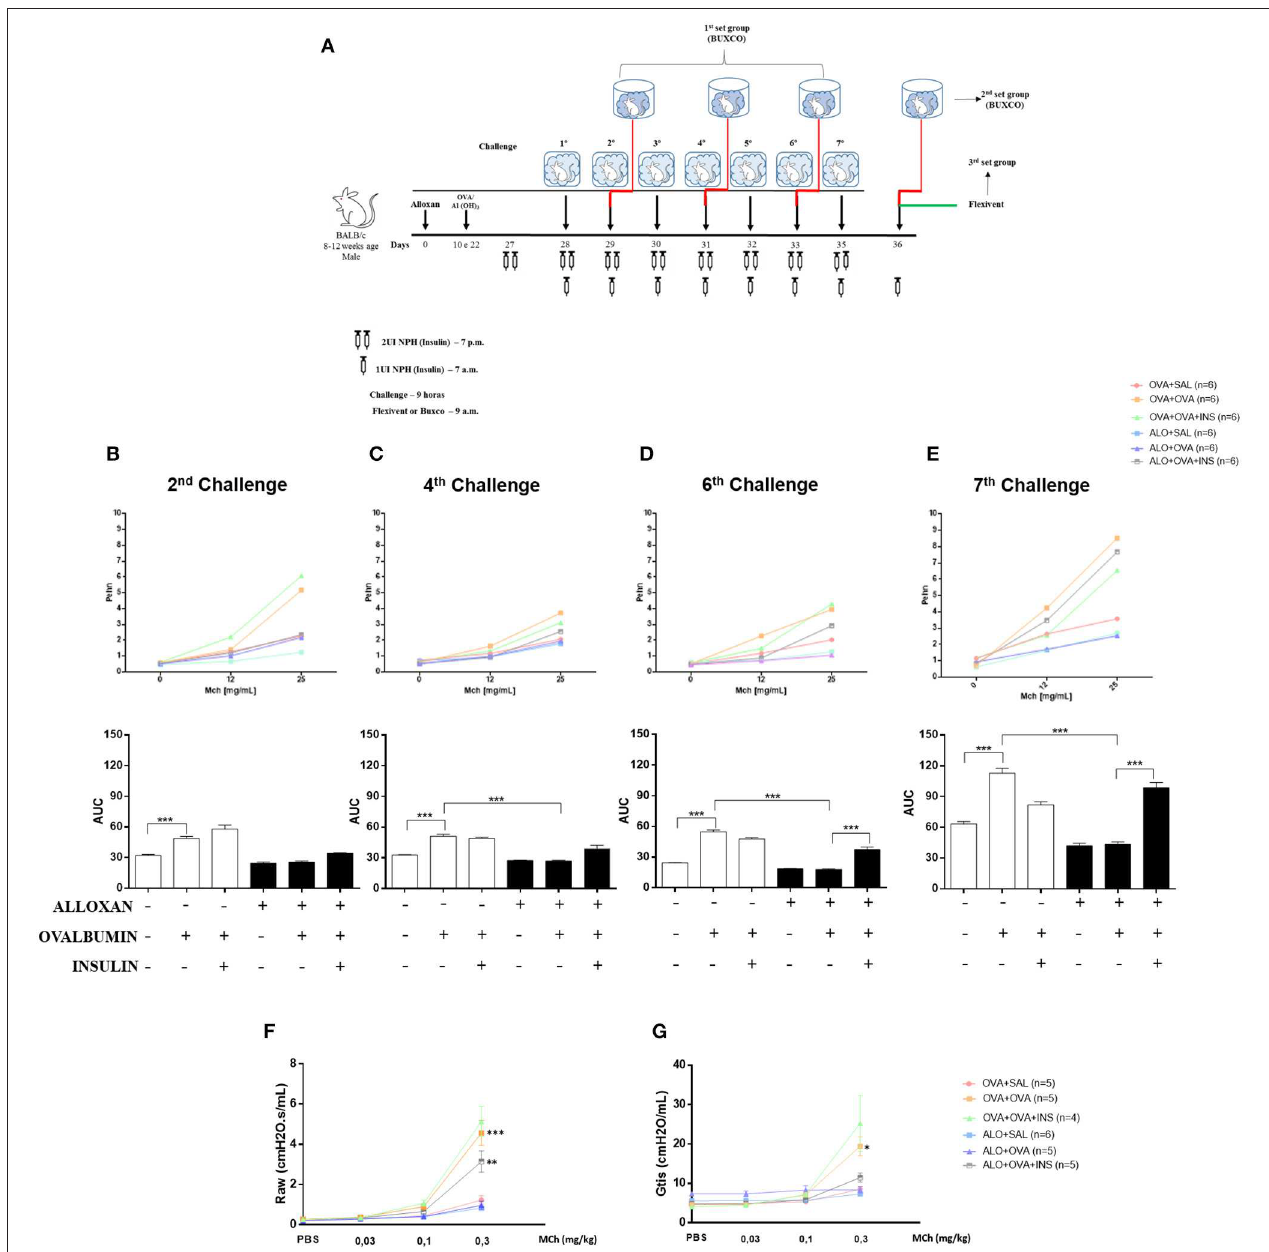
FIGURE 7 | The role of insulin in respiratory mechanics. Methacholine capacity (MCh) was evaluated in mice. (A) Experimental protocols for BUXCO and FlexiVent. (B) The 2nd challenge. (C) The 4th challenge. (D) The 6th challenge. (E) The 7th challenge. (F) Raw. (G) Gtis. Values represent the mean ± SEM from three independent experiments ( n = 4–6 animals per group). * p < 0.05; ** p < 0.01; *** p < 0.001. The groups were tested with two-way analysis of variance followed by Tukey–Kramer post-hoc tests for the BUXCO condition and Bonferroni tests for the FlexiVent condition (GraphPad Prism version 6.0 for Windows, GraphPad Software, La Jolla, CA,